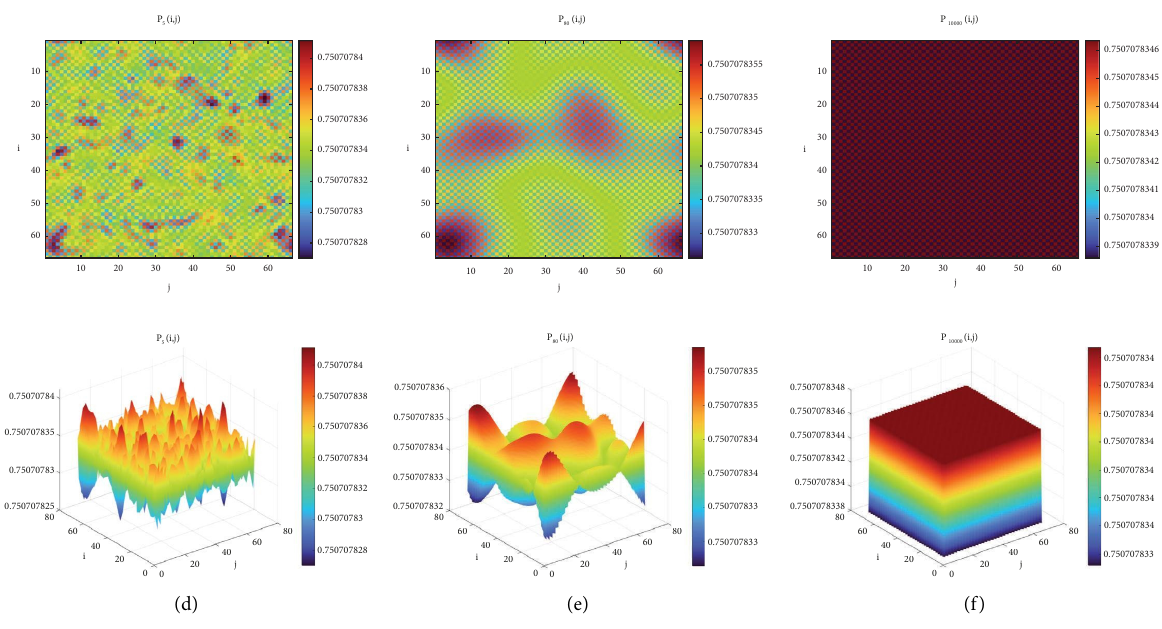
Figure 14: R � 2 ,k � 1, c � 0 . 8, σ ∗ � 0 . 278655, σ � 0 . 5, ( d which is consistent with the case of Corollary 3(3), a Flip bifurcation occurs, parasite and host populations exhibit period-doubling in two- dimensional space.